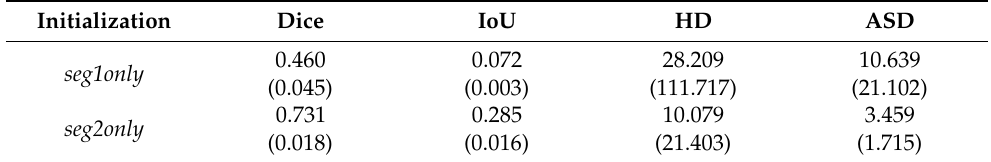
Table 3. The Dice, IoU, HD, and ASD values show that Generator 2 performs better than Generator 1. The experiment was conducted using only 100 labeled data points of the Hippocampus